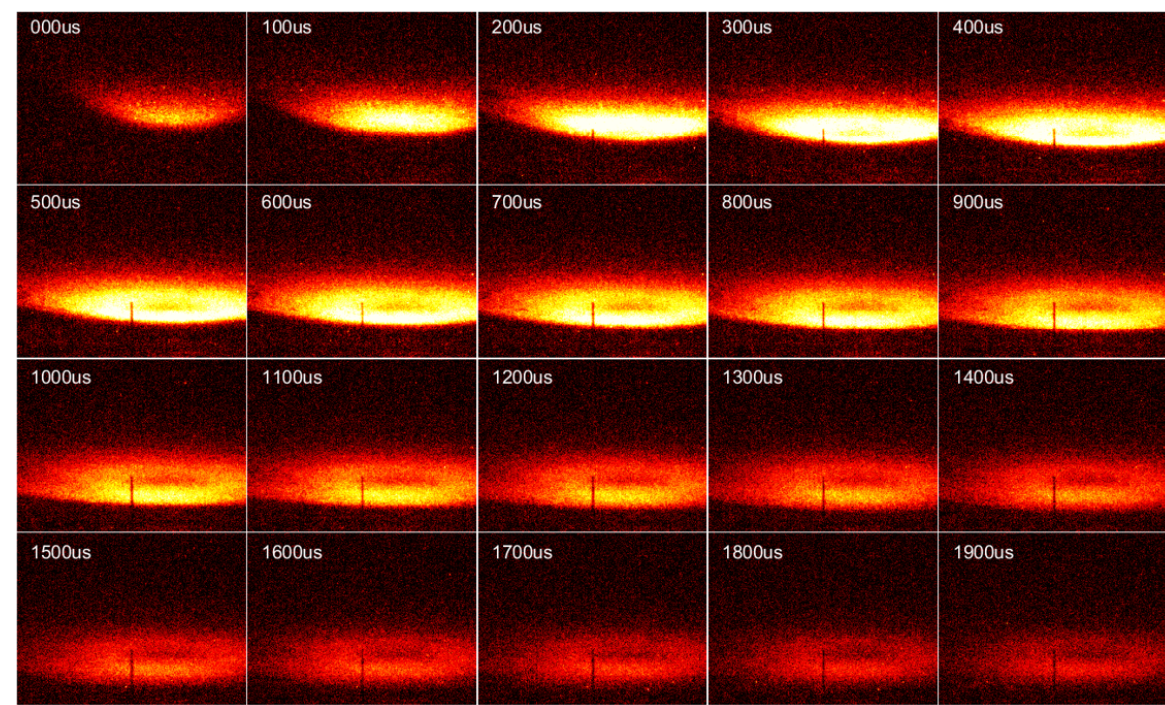
Figure 4. A sequence of temporal-integrated images recorded by the high-speed camera system at 10,000 fps for the elve event at time 13:07:25.9316 on 22 June 2020 where each exposure time is close to 100 μ s.